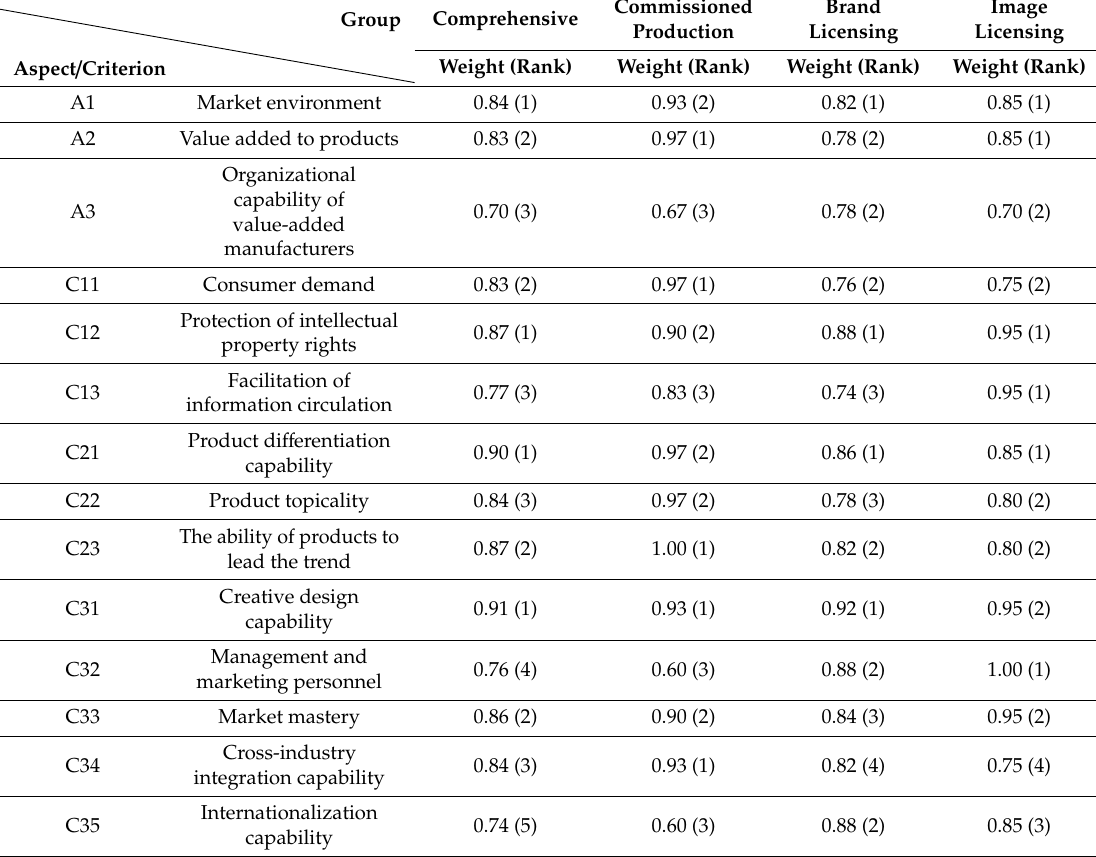
Table 4. Weights of aspect and criterion for each